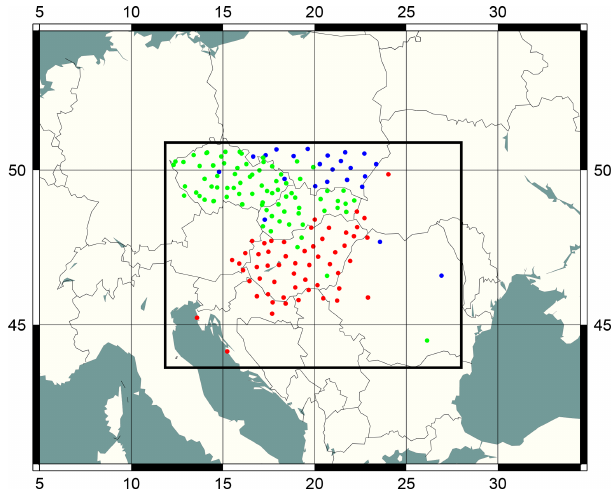
Figure 1. The computational domain of AROME/Hungary (black rectangle) and all available GNSS stations from SGO1 (red), GOP1 (green) and WUEL (blue) E-GVAP networks.